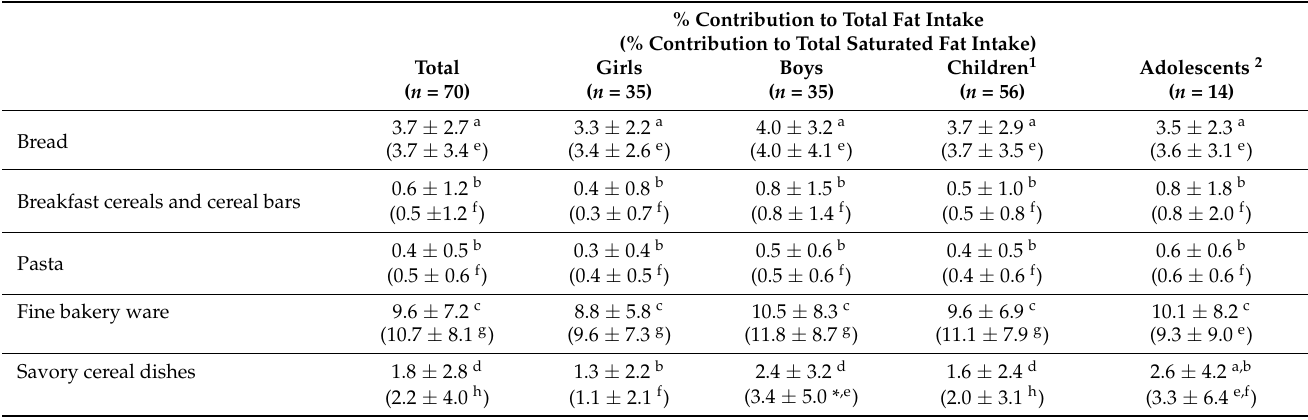
Table 5. Contribution of the different types of gluten-free products of to the daily fat and saturated fat intakes in Spanish children and adolescents, both genders, with celiac disease.